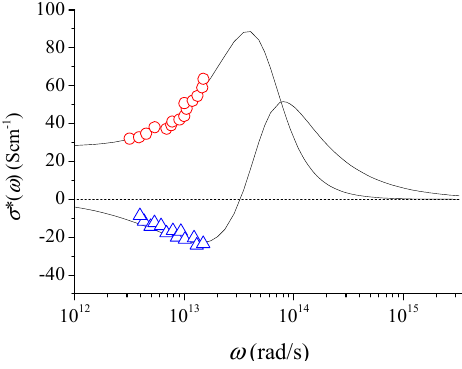
Figure 3. Complex conductivity in nanocrystalline Si films. Open circles and triangles are experimental results of the real and imaginary parts of conductivity, respectively; data extracted from [8]. Solid lines are conductivity predicted from the SSFTC model.